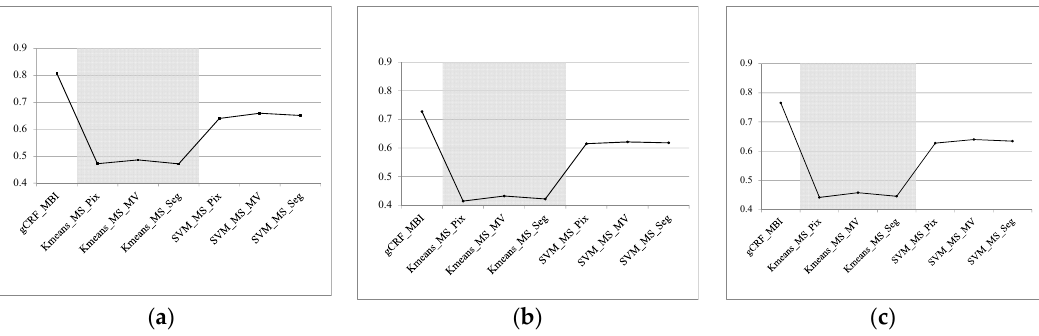
Figure 14. Quantitative evaluation of the spectral-based methods using the QuickBird image: ( a ) recall; ( b ) precision; and ( c ) F -value.